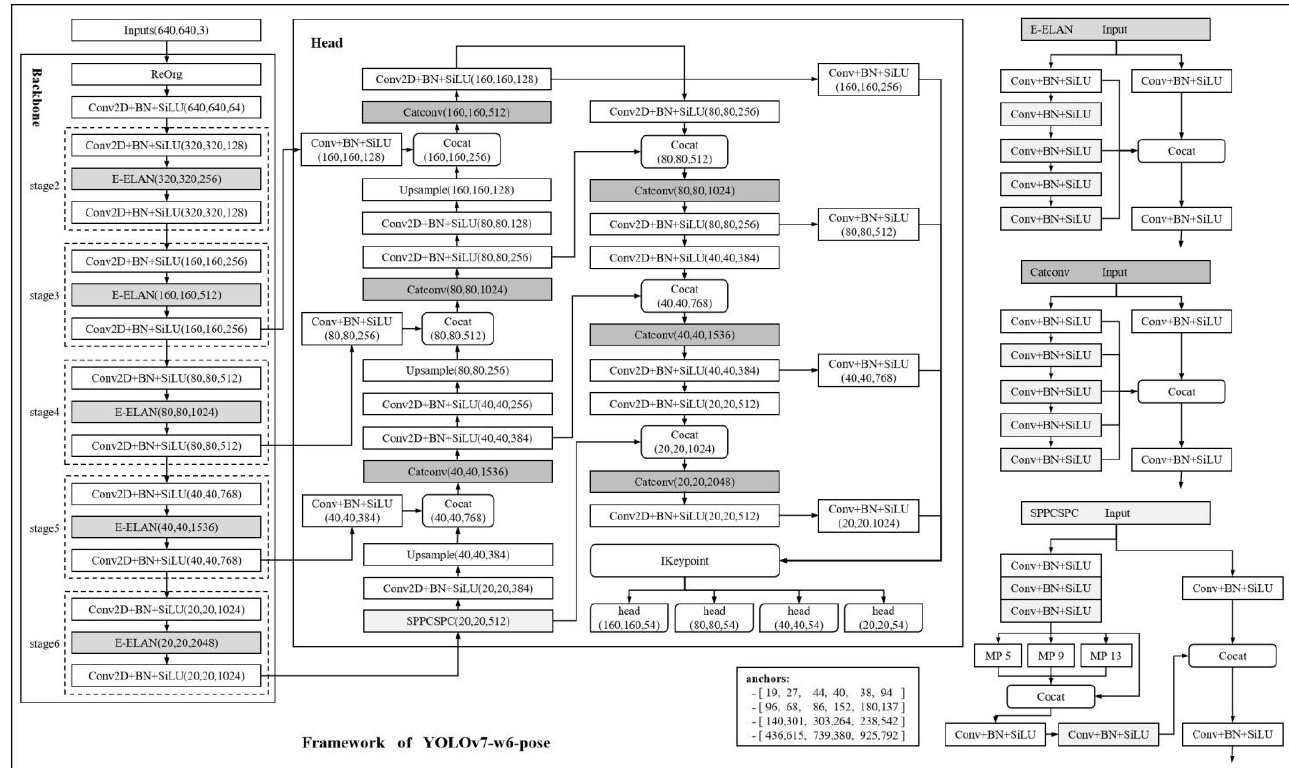
Figure 11. The framework of YOLOv7-pose.